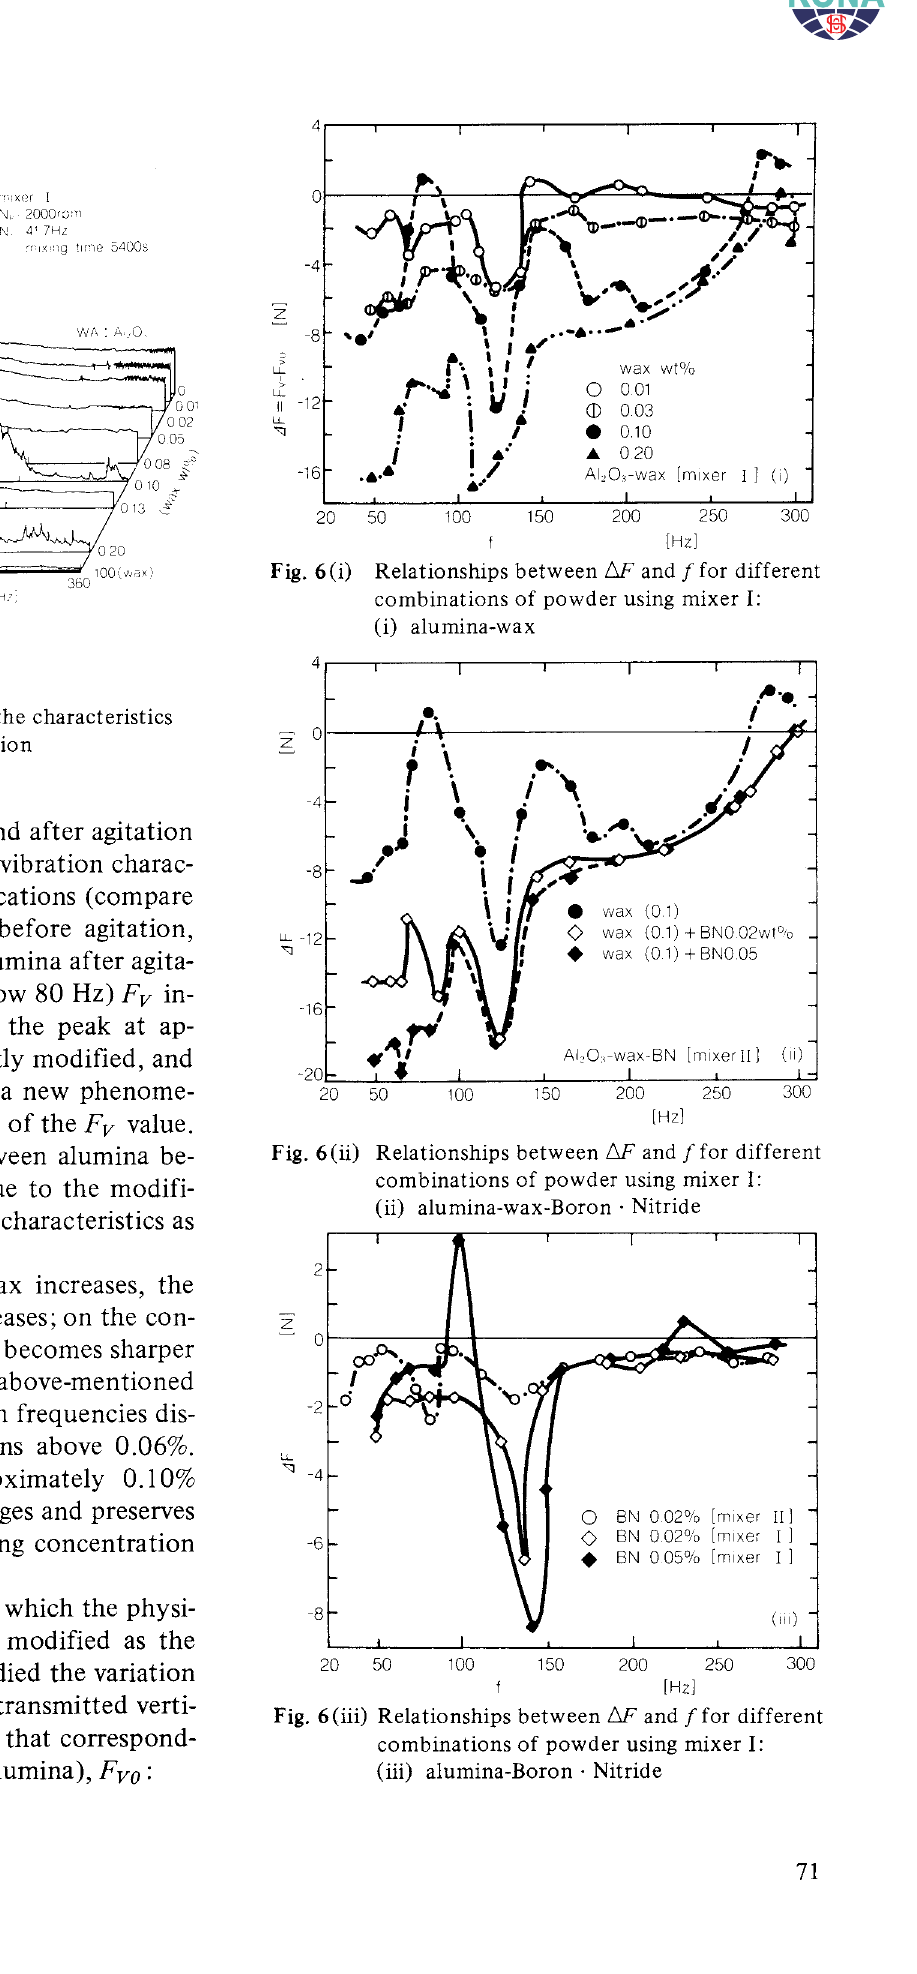
Fig. 6(i) Relationships between M and f for different combinations of powder using mixer I: